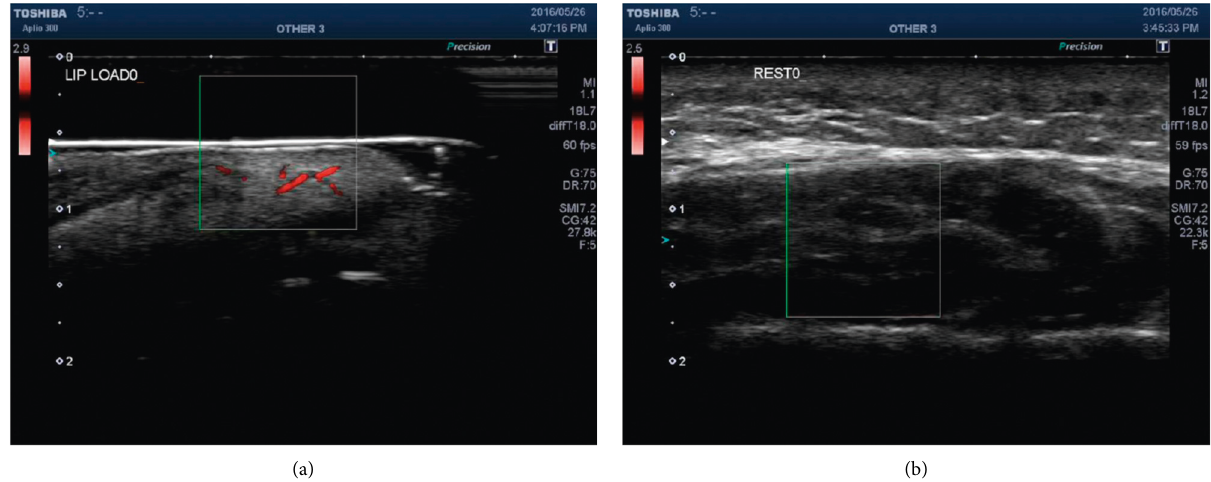
Figure 2: (a) Deeper half of the region of interest (ROI) was matched to the superior orbicularis oris muscle. (b) The ROI was included in the